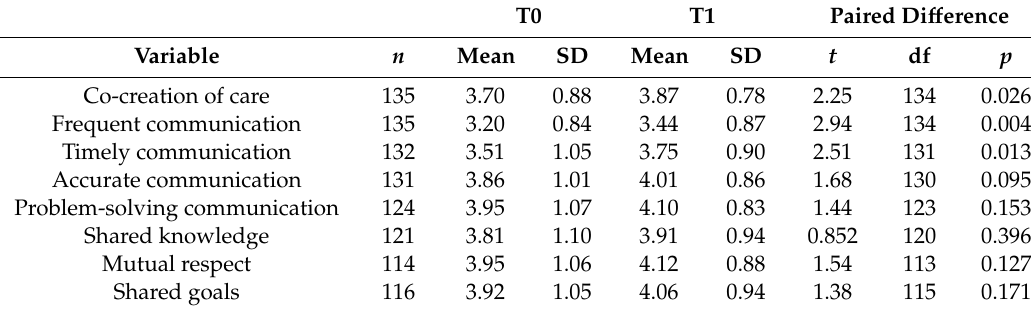
Table 2. Paired sample t tests (aspects of) co-creation of